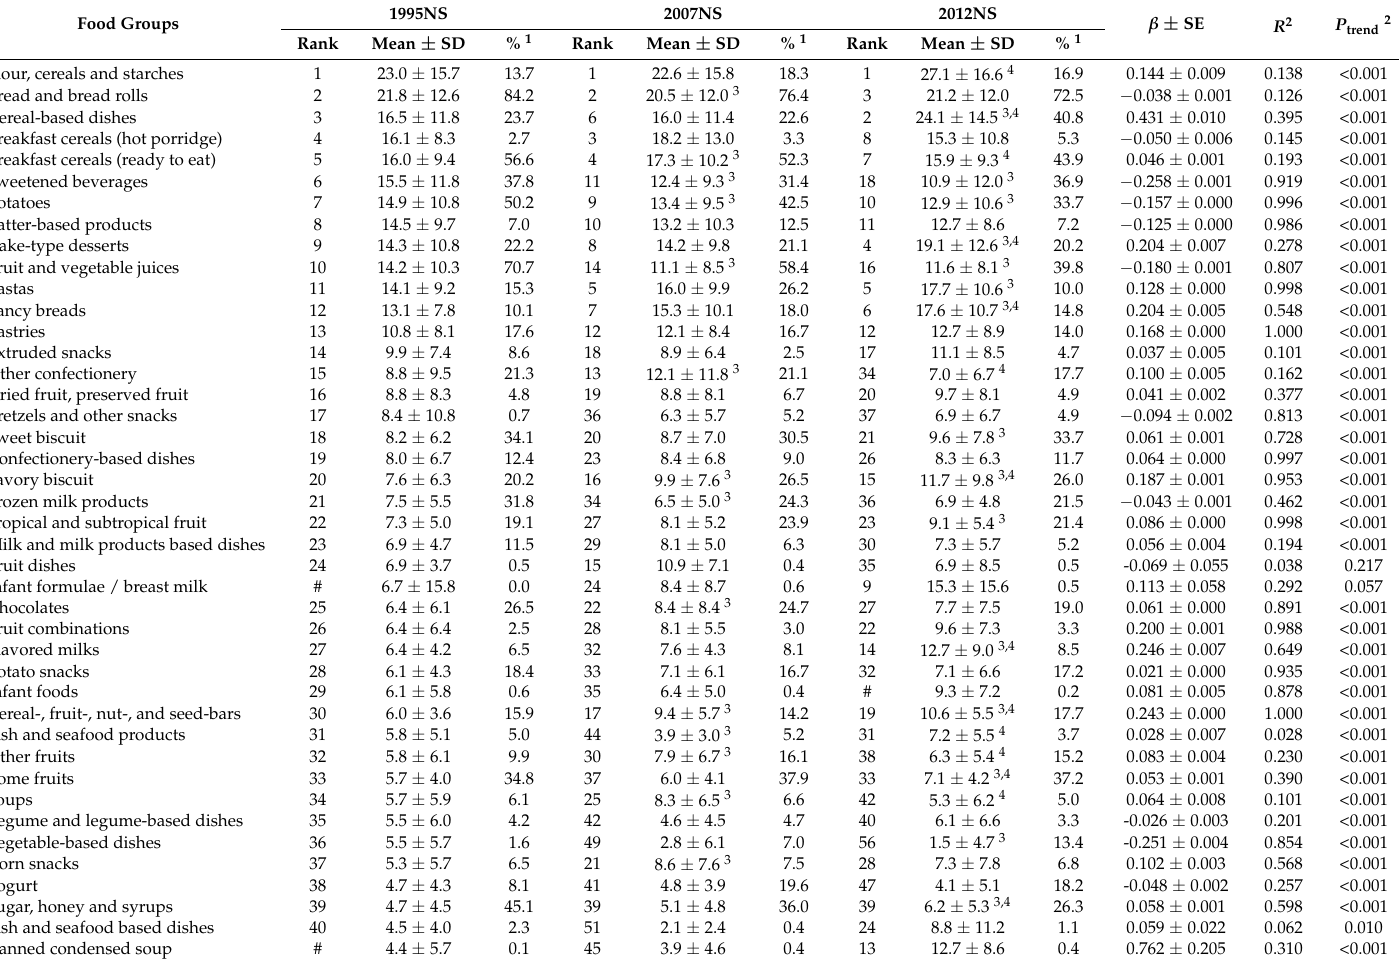
Table A3. Per consumer mean ± SD comparison of the highest contributors to glycemic load in the three surveys—all subjects included. Food Groups Flour, cereals and